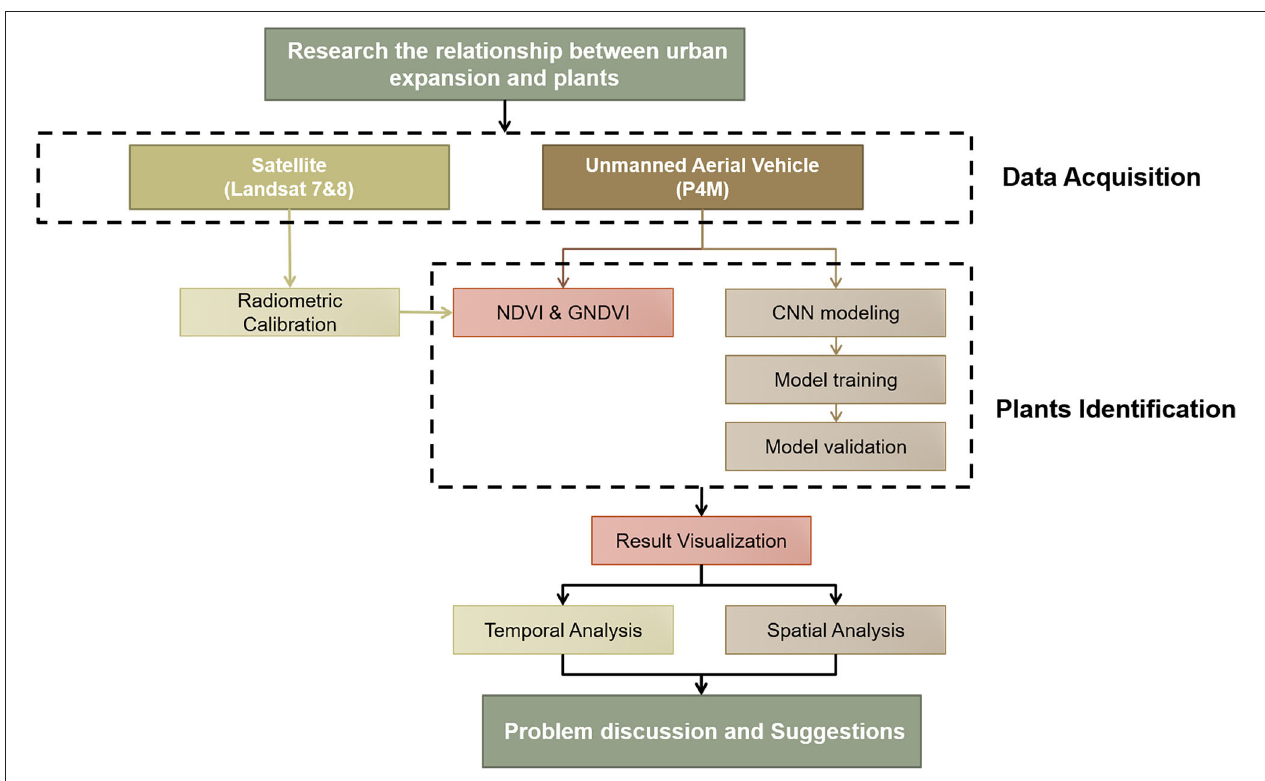
FIGURE 1 | The process of